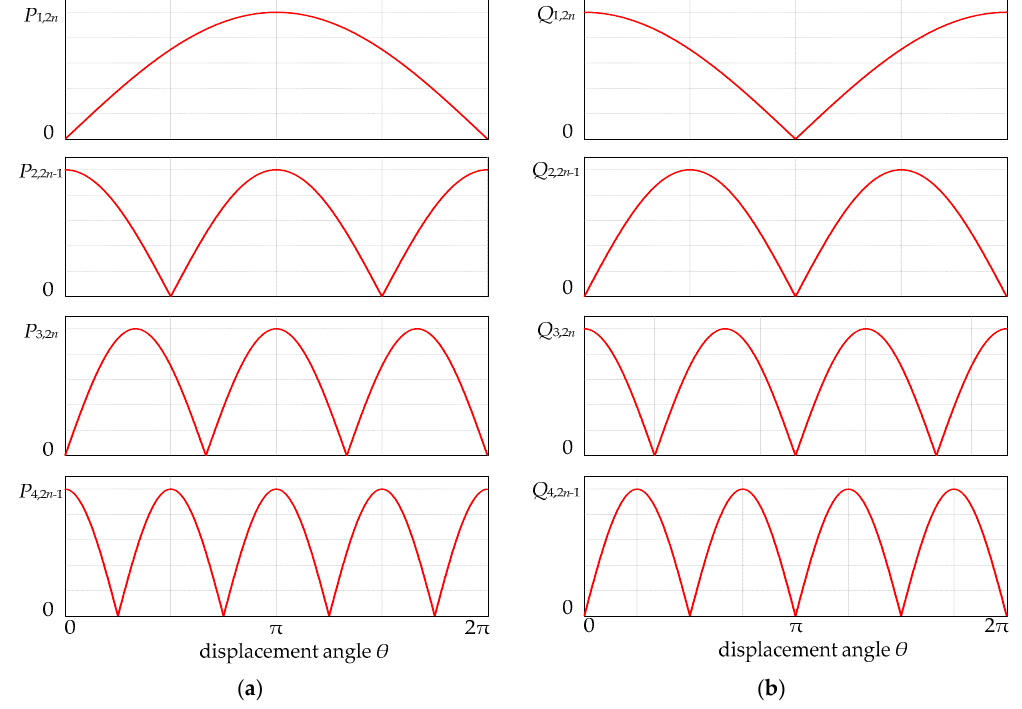
Figure 4. Magnitudes of the harmonic components for the phase voltage and circulating current with different displacement angles: ( a ) magnitudes of harmonic components for phase voltage; and ( b ) magnitudes of harmonic components circulating current.